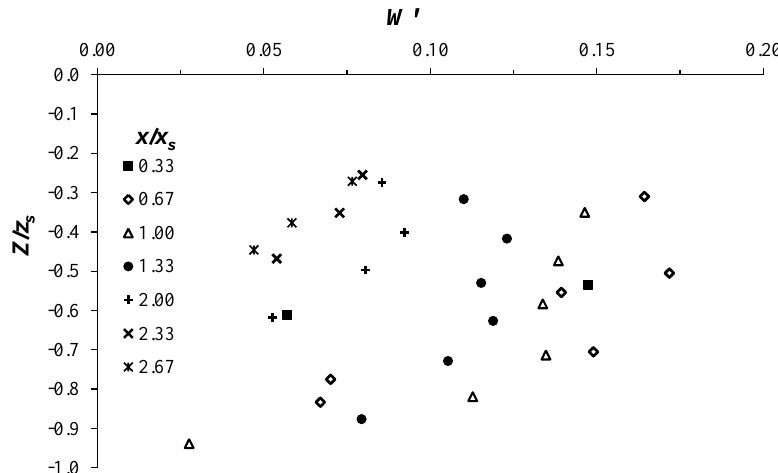
Figure 4. Profiles of vertical turbulence intensity, W ′ , at different downstream positions x / x s along the plane of flow symmetry ( y = 0).